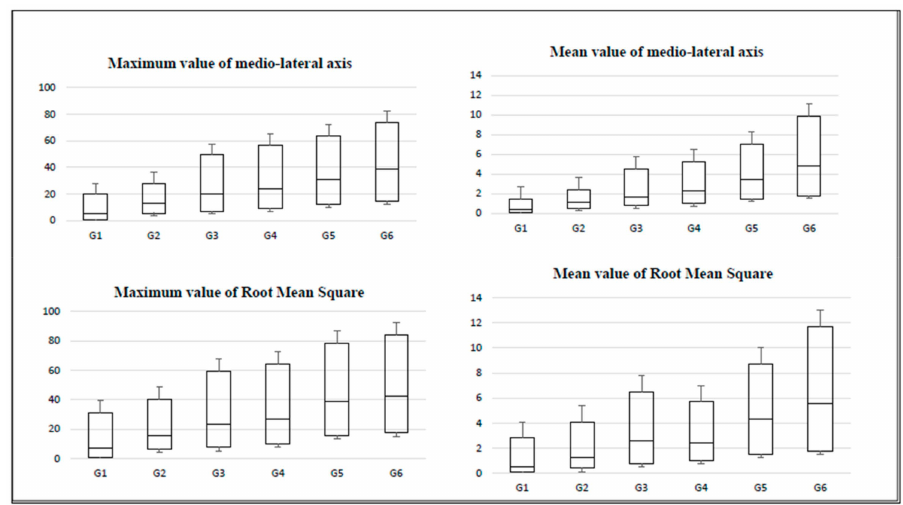
Figure 4. Box charts for the monopodal balance test on unstable surface